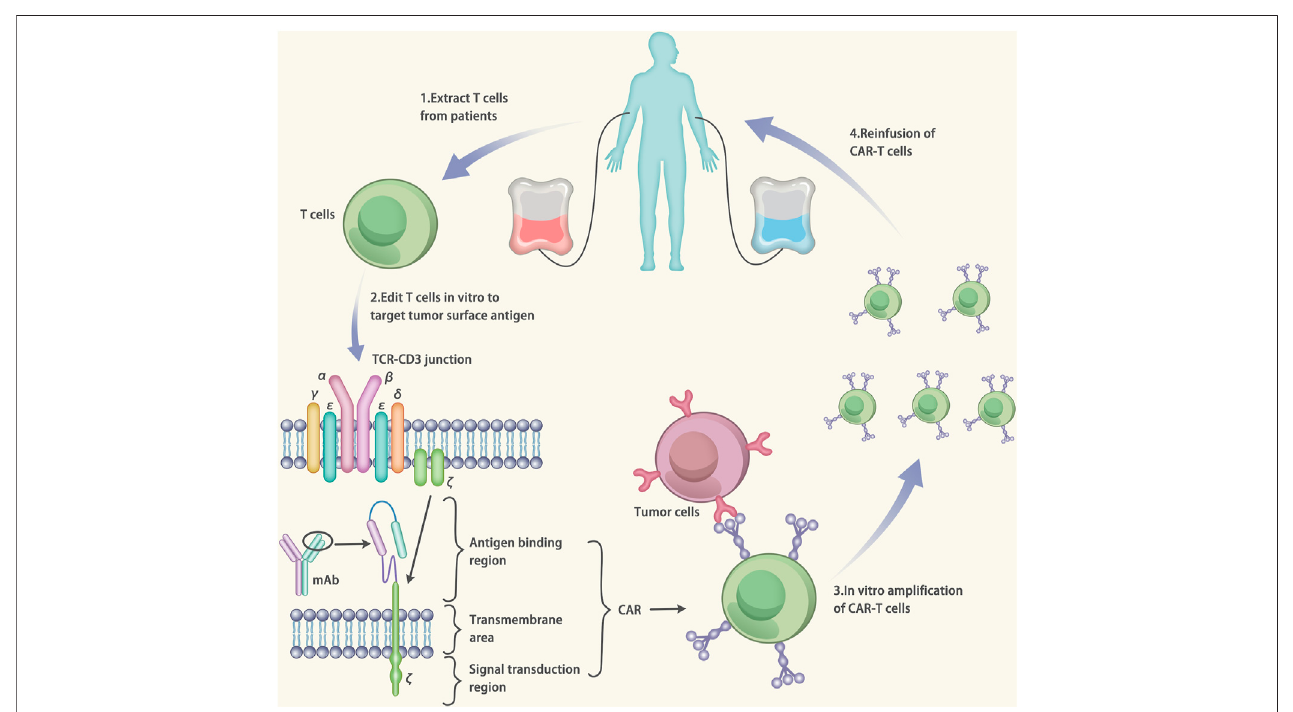
FIGURE 6 | Mechanisms of Chimeric antigen receptor T-cell (CAR-T) therapy. The CAR is made up of three components: 1) an antigen binding region, which consists of a single-chain fragment variable (scFv). The scFv can speci fi cally target to the antigens. 2) the transmembrane area, which fi xes the scFv on the surface of Tcells.3)signaltransductionregion,whichconsistsofCD3- ζ chainoftheTcell.ThegeneoftheCARisdesignedbasedonthetarget antigen.Afterthat,theTcellswere extractedfrom the patients and transfected byvectors carryingtheCAR gene. Thetransfection results inthe expression oftheCARon the surfaceof Tcells(CAR- T cells). The CAR-T cells are ampli fi ed in vitro and injected into the patients to cure the